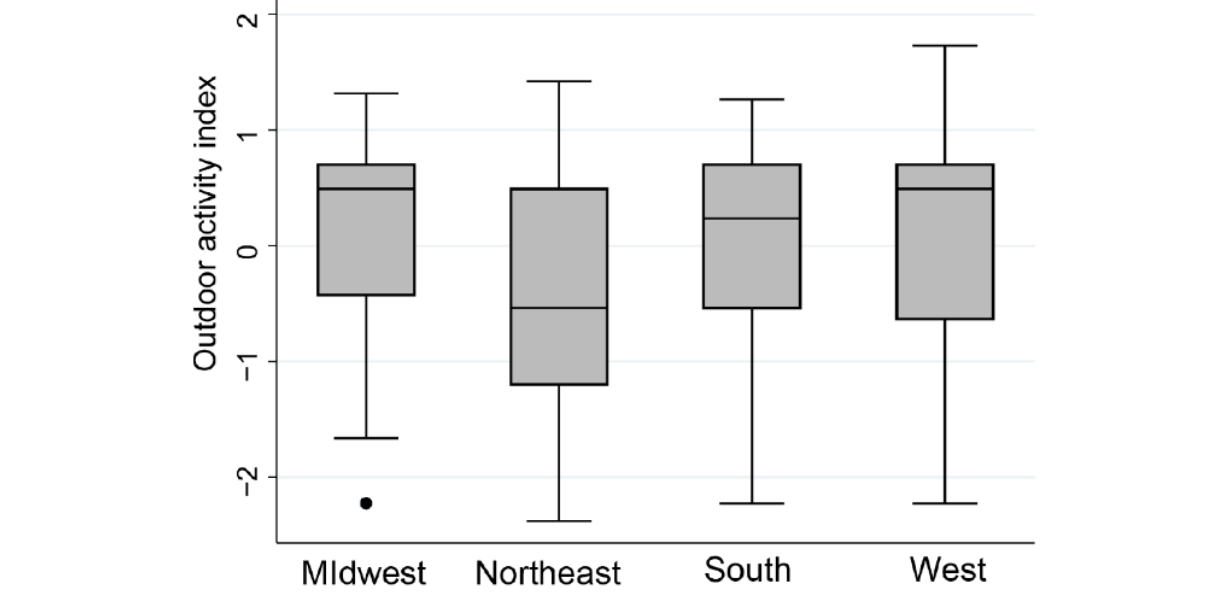
Figure 5. The outdoor activity index derived from the multiple correspondence analysis (MCA) excluding age and gender, by the major census regions in the United States.